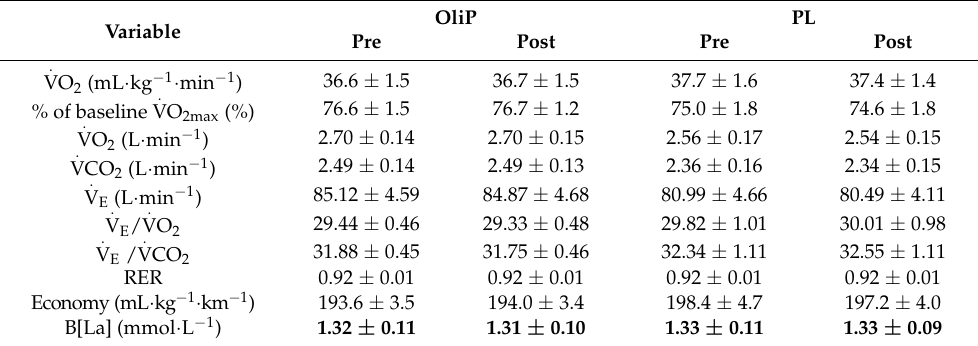
. VCO 2 = volume of carbon dioxide;